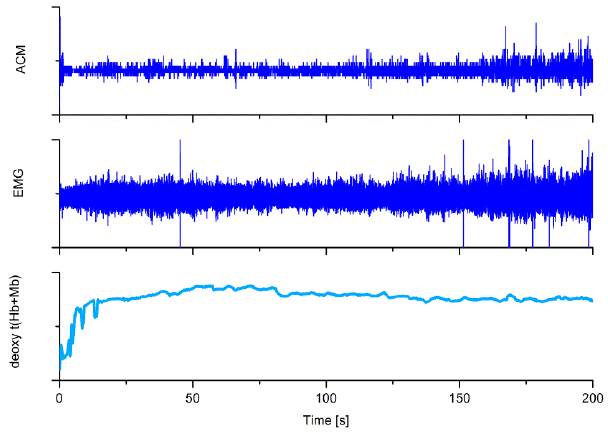
Fig. 5. The response of the ¯rst isometric contraction of Subject 4. Subject 4 holds up the 5 kg weight for 200 s.